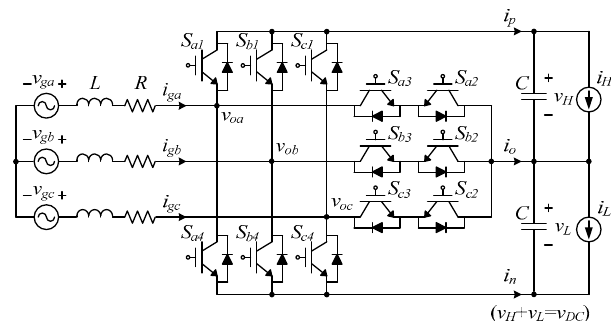
Figure 1. T-type three-level PWM converter system.